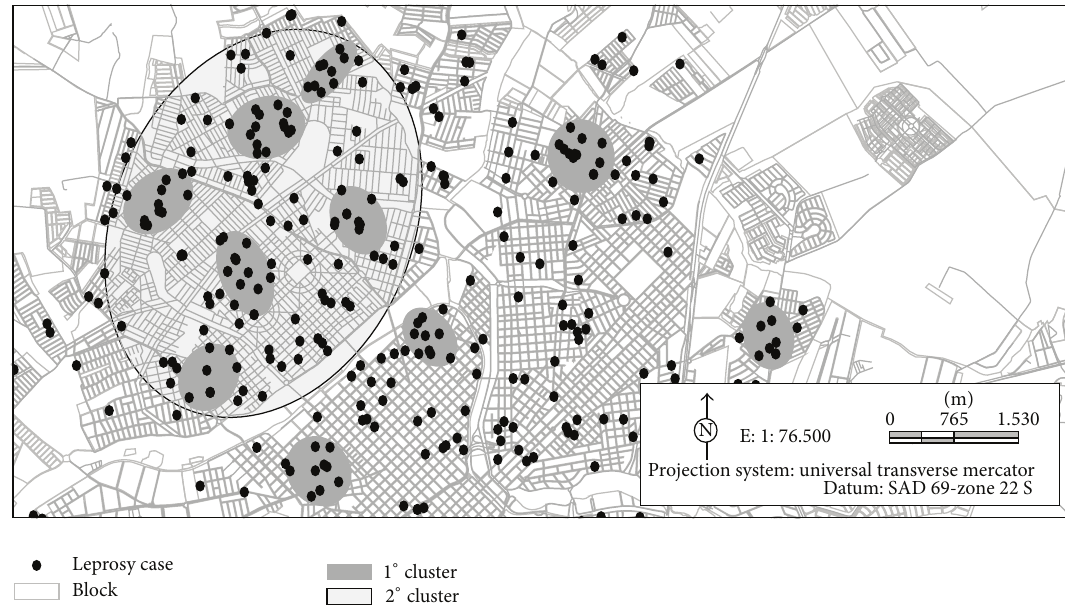
Figure 2: Constitution of the ten clusters formed by grouping the residences of leprosy cases as first order (dark gray) and second order (light grey) in the period from 1998 to 2010 in S˜ao Jos´e do Rio Preto,